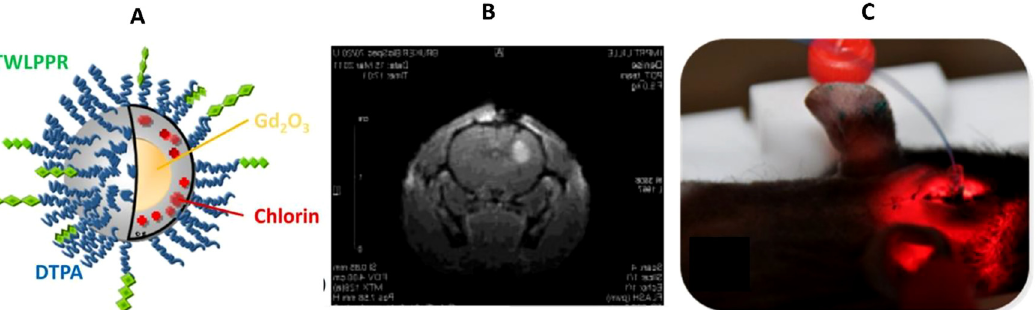
Figure2: (A)SchematicpresentationofNP-TPC-ATWLPPR,(B)maximalMRIsignalintensityafterinjecting84.2 μ molofGdforabodyweightof 250gforcerebralbiodistributionandbraintumortissueselectivityof NP-TPC-ATWLPPR,and(C)overviewclinicalpictureof thedeviceapplied on the mice [32] with permission from Elsevier and Copyright Clearance